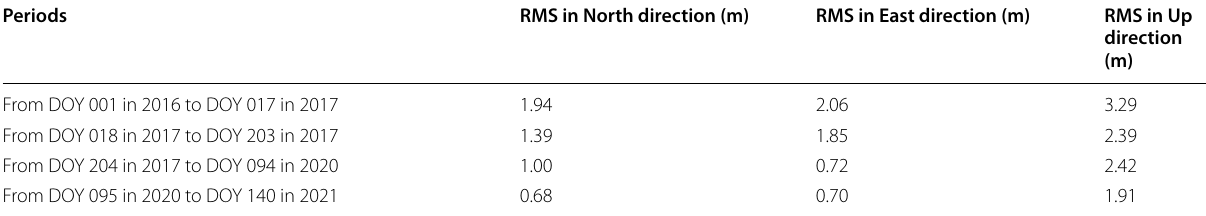
Table 2 Mean SPP position RMS (in meter) at station KARR (Australia) in the north, east, and height component of the four periods from Jan. 2016 to April 2021 Periods RMS in North direction